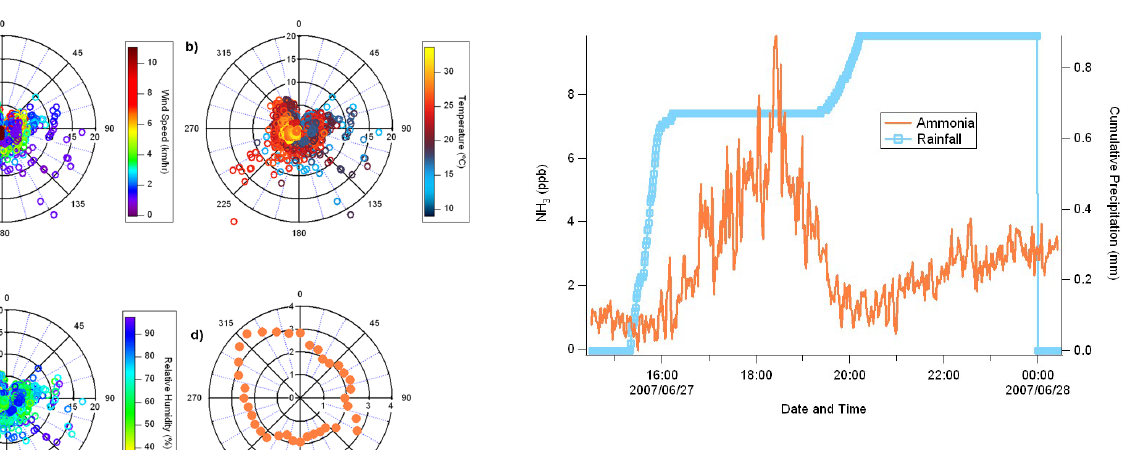
Fig. 3. One example of a precipitation event that was followed by a significant increase in ammonia mixing